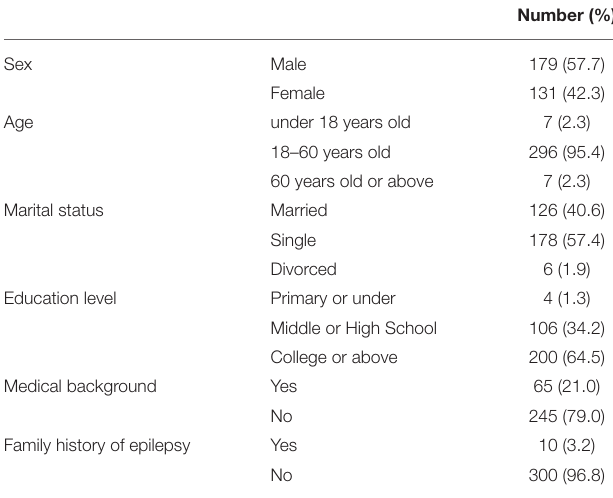
TABLE 1 | Demographic characteristic of participants ( n =